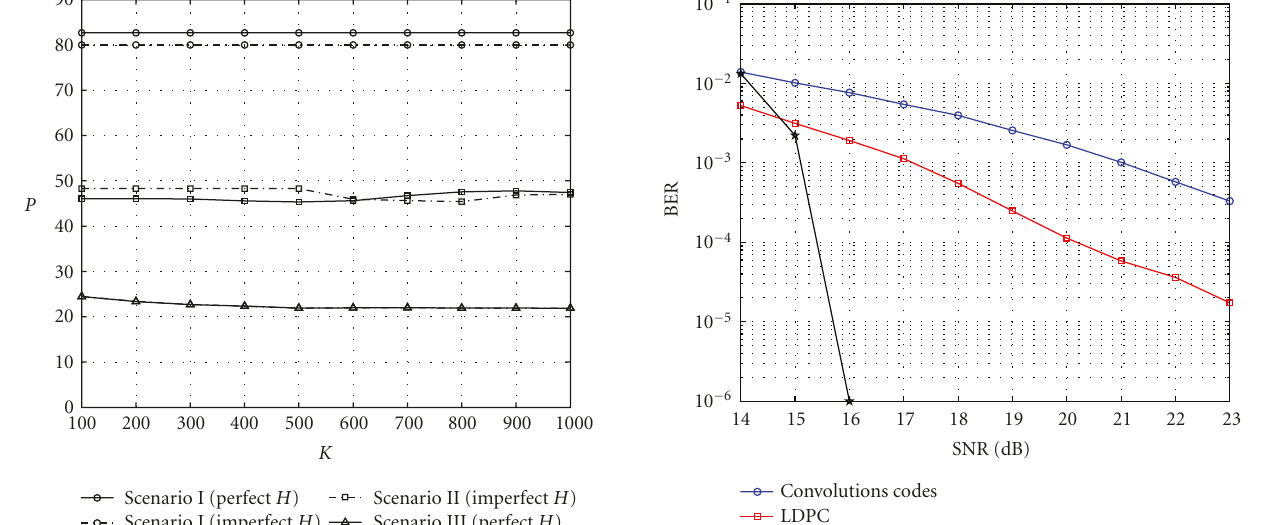
curves overlap but this does not happen in Scenario I and